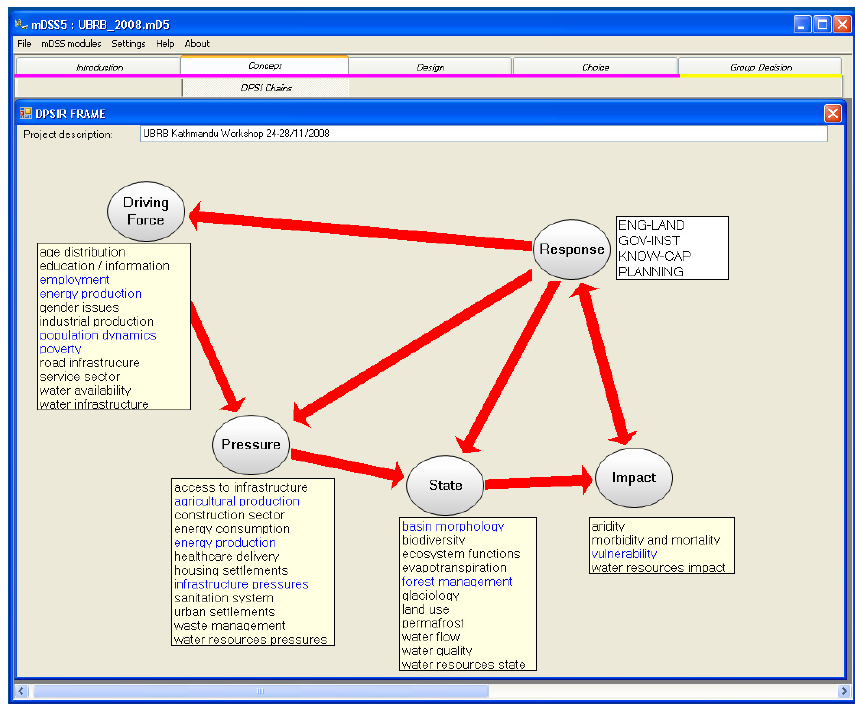
Figure 1. The conceptualisation of the information base stored in the IIT within the DPSIR framework (screenshot of the mDSS